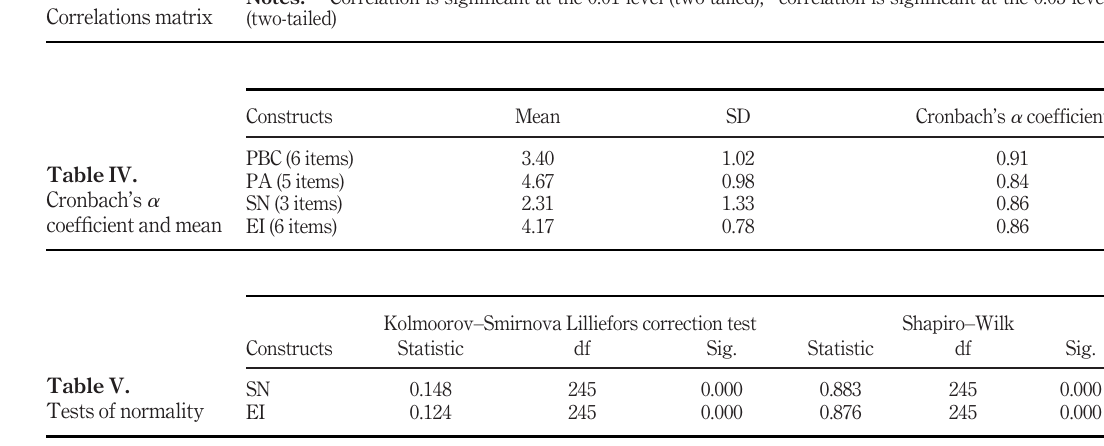
Table III. Correlations matrix